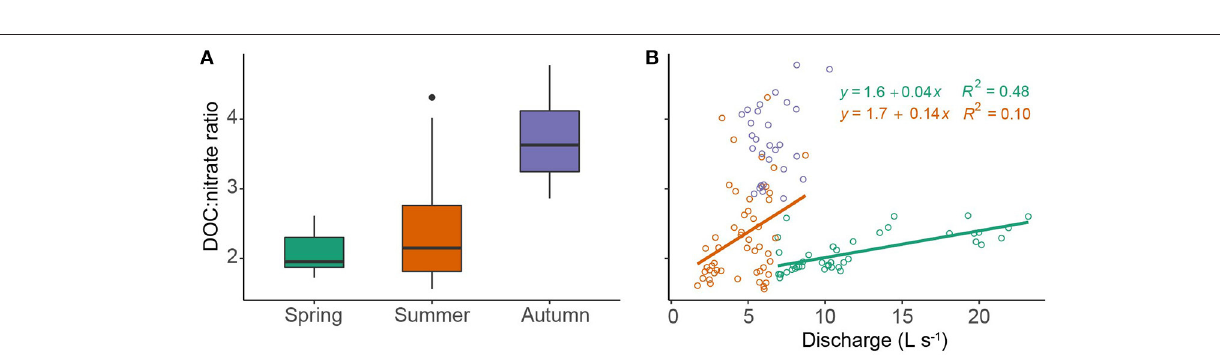
FIGURE 7 | (A) Seasonal variability in the DOC:nitrate molar ratio and (B) relationship between the DOC:nitrate molar ratio and discharge. Lines of best fit were fitted using ordinary least squares regression. Colour codes for seasons are the same in both panels with lines representing significant ( P < 0.05) fitted values based on ordinary least squares